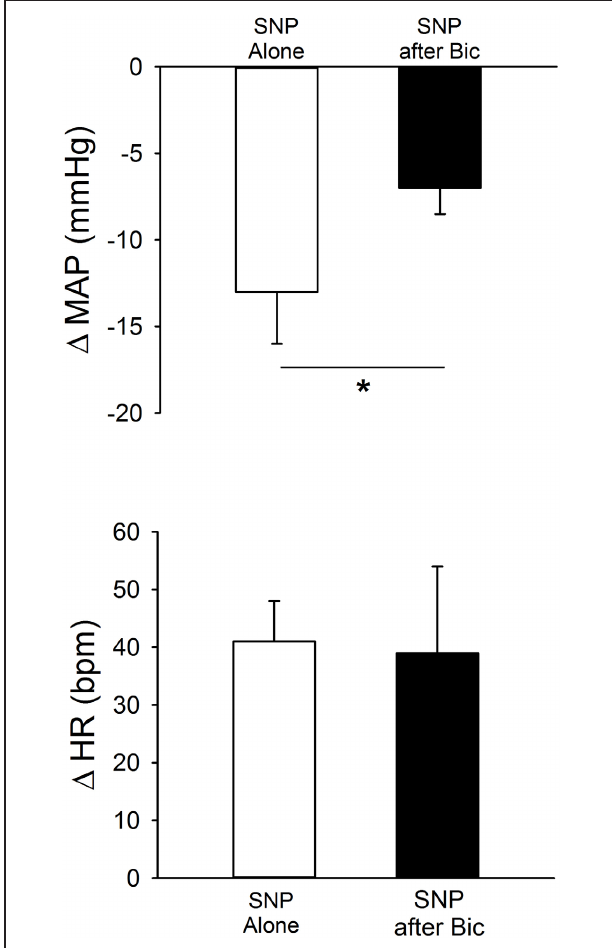
FIGURE 4 | MAP and HR effects of unilateral microinjection of the NO donor sodium nitroprusside (SNP, 1.0M) into the PVN of conscious rats ( n = 6). SNP was injected before (open bars) and after (filled bars) blockade of GABA A receptors with bicuculline (Bic, 1mM). SNP alone produced significant decreases in MAP, accompanied by tachycardia. Bic significantly attenuated the depressor effect of SNP ( ∗ p ≤ 0 . 05) without altering the tachycardia.